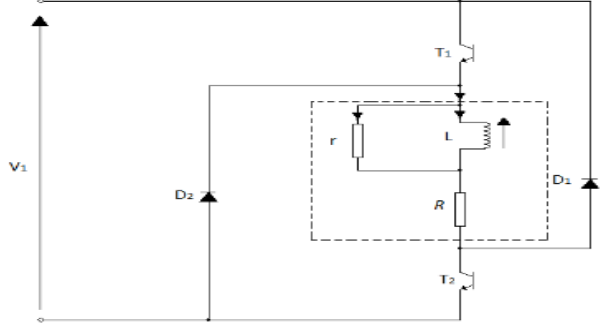
Fig. 1. Equivalent circuit diagram of